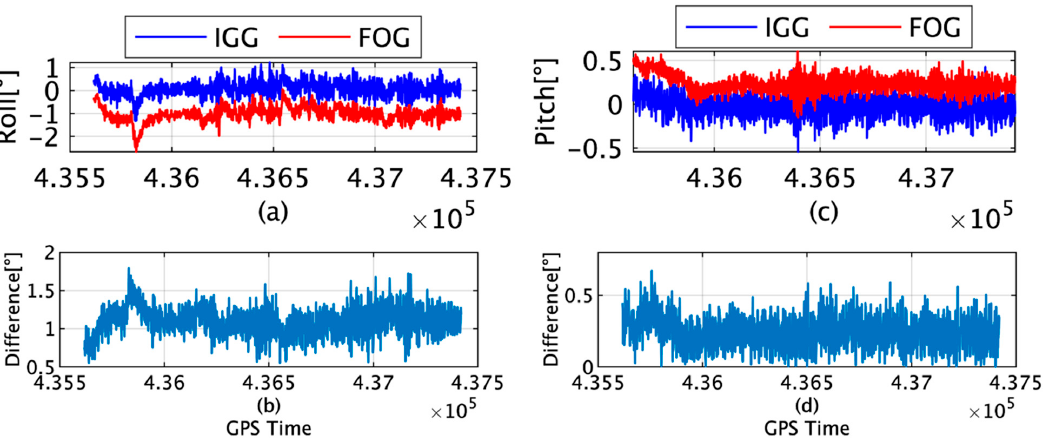
Figure 5. ( a ) Roll angle of IGG and FOG; ( b ) roll difference (RMS) between IGG and FOG; ( c ) pitch angle of IGG and FOG; ( d ) pitch difference (RMS) between IGG and FOG.